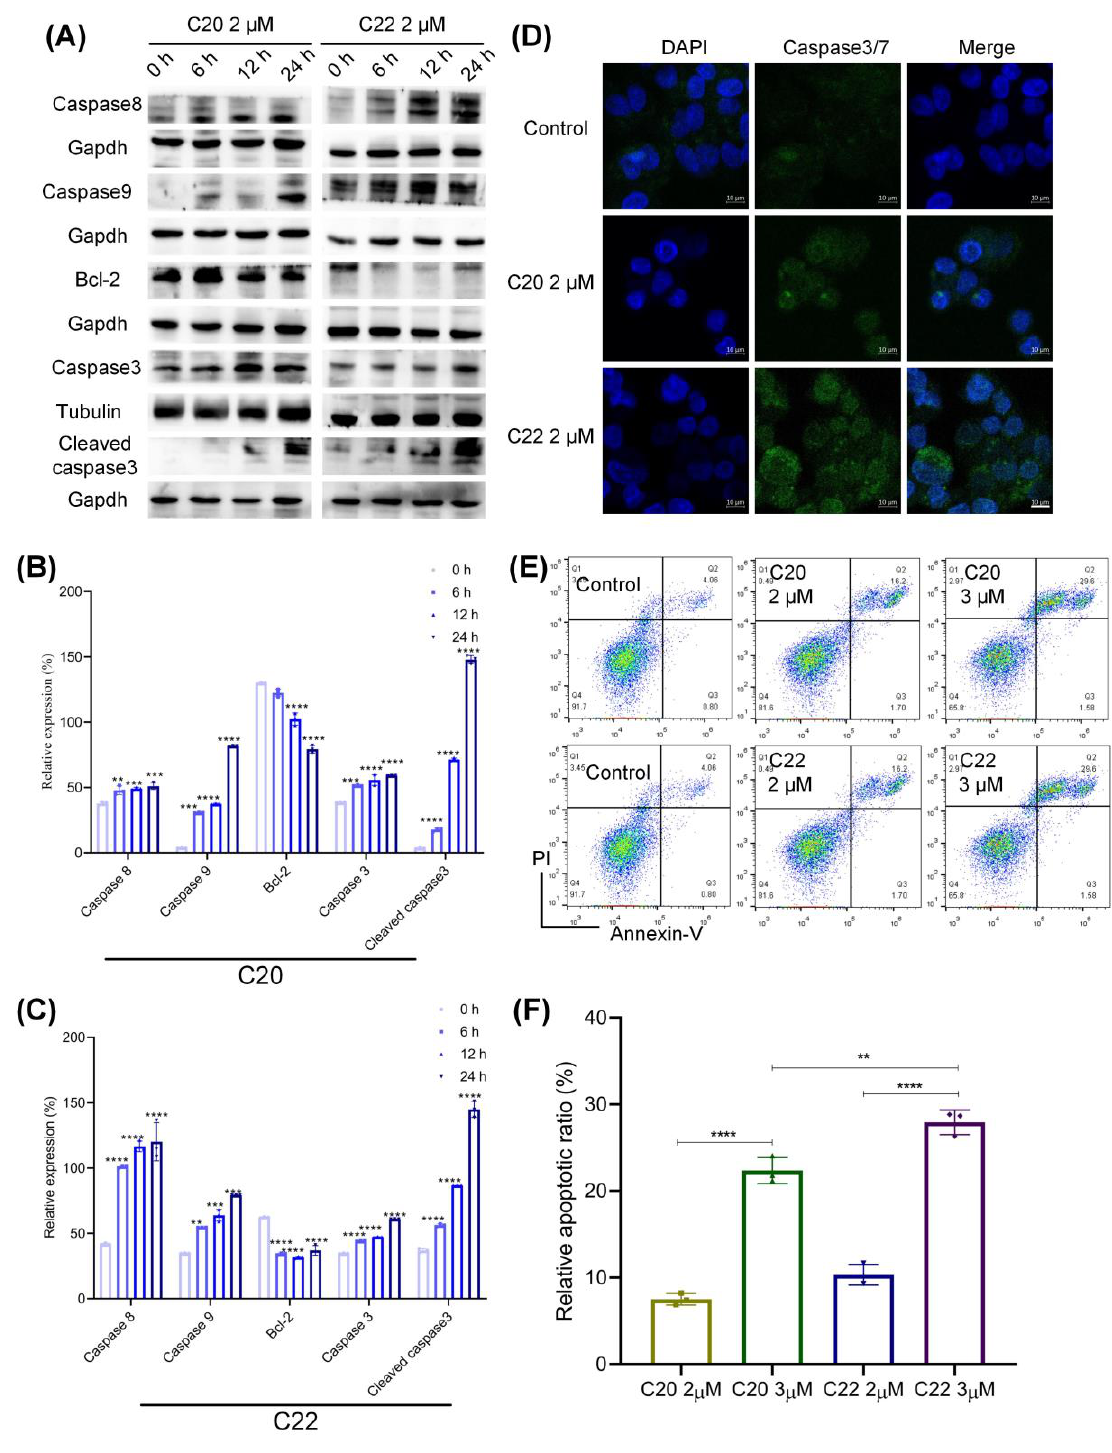
Figure 8. Treatment with C20/C22 led to increased proapoptotic protein expression and a caspase cascade response. ( A – C ) WB analysis of the antiapoptotic and caspase proteins in HepG2 cells treated with C20/C22 at 2 µ M for 0, 6, 12, and 24 h. The reported values correspond to the mean ± SD for three independent experiments. ( D ) Immunofluorescence assays employed to determine the expression of caspase3/7 in cells with indicated treatments. Scale bars, 10 µm. ( E , F ) Apoptotic cells detected by flow cytometry after indicated treatments ( n = 3). The p -value was analyzed by one-way ANOVA followed by Tukey’s test using GraphPad Prism version 8.00. ** p < 0.01, *** p < 0.001, and **** p < 0.0001 vs. 0 h/control group.